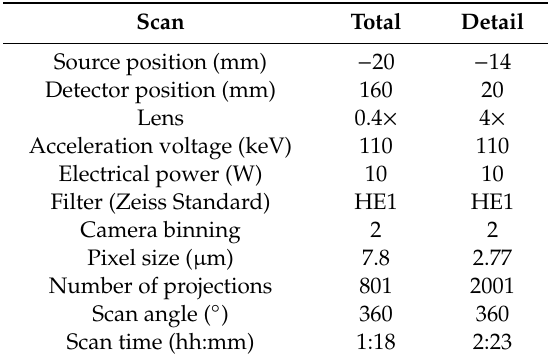
Table 1. Scan parameters from X-ray computed tomography (XCT) analysis.